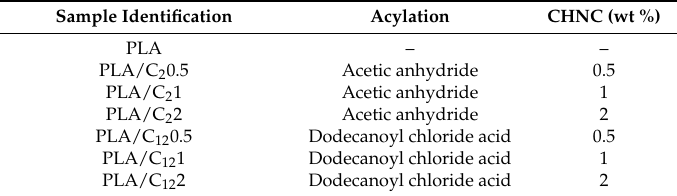
Table 1. Identification of the PLA/C 2 CHNC and PLA/C 12 CHNC